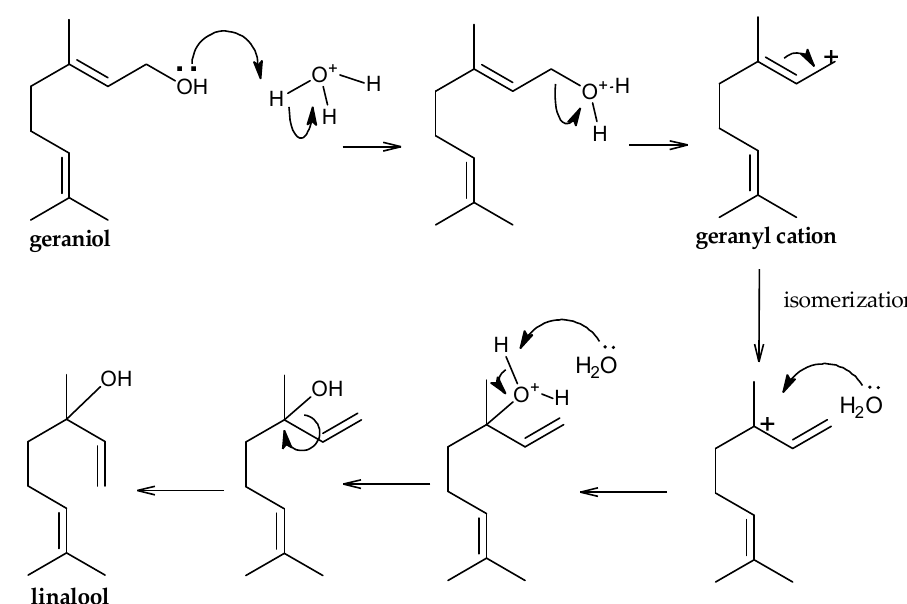
Figure 3. Chromatograms of the geraniol ( a ), hydrodistillation of geraniol ( b ) and solution of hydrodistillation of geraniol + linalool ( c ).